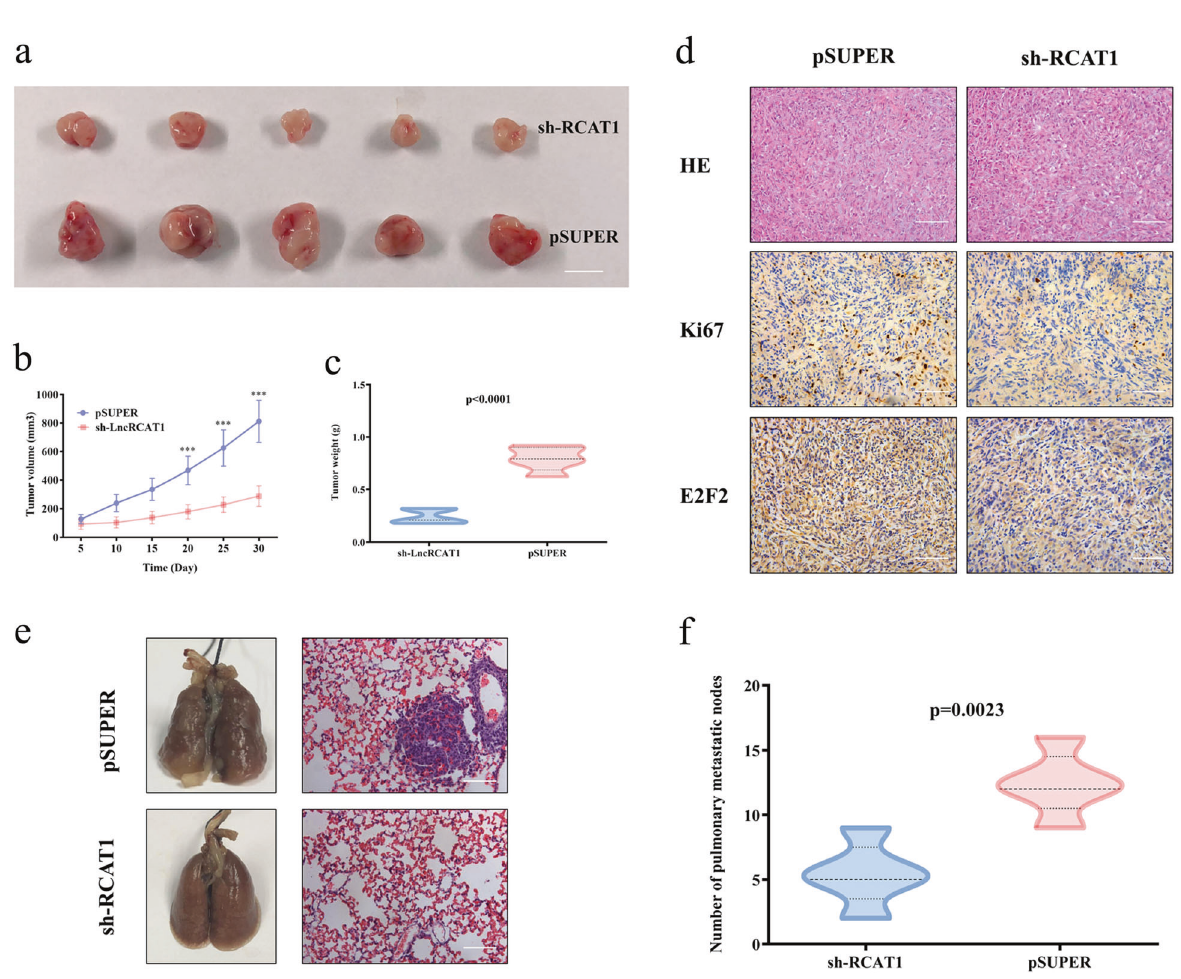
Fig. 8 lncRNA RCAT1 knockdown suppresses tumor proliferation and metastasis in vivo. a – c The photos ( a ), growth curve ( b ), and weight ( c ) of the xenograft tumors. Scale bar, 1 cm. d H&E staining of the xenograft tumors. IHC results of Ki67 level and E2F2 level in xenograft tumor tissues. Scale bar, 100 μ m. e Representative images of lung metastatic nodules and H&E staining of lungs isolated from nude mice ( n = 5 for each group). Scale bar, 100 μ m. f The numbers of metastatic nodules in the lungs of nude mice were calculated and compared. Scare bar = 50 μ m ( *** P <